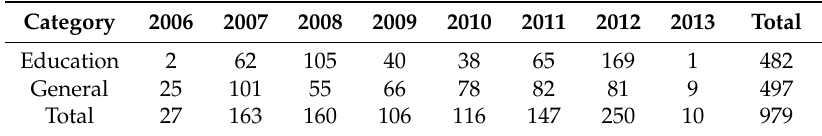
Table 2. Status of the yearly spread of